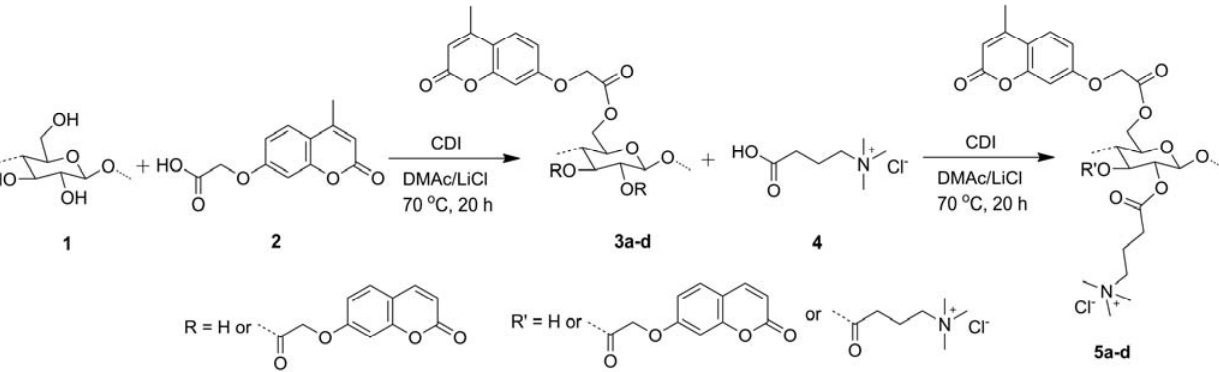
Figure 11. Synthesis route of cellulose 2-[(4-methyl-2-oxo-2H-chromen-7-yl) oxy] acetates (3a-d) and cellulose acetate [4-( N , N , N -trimethylamonium) chloride] butyrates (5a-d) via in situ activation of (2) and (3-carboxypropyl) trimethylammonium chloride (4) with N , N -carbonyldiimidazole (CDI) in DMAc/LiCl. Reprinted with permission from [67]. Copyright 2012